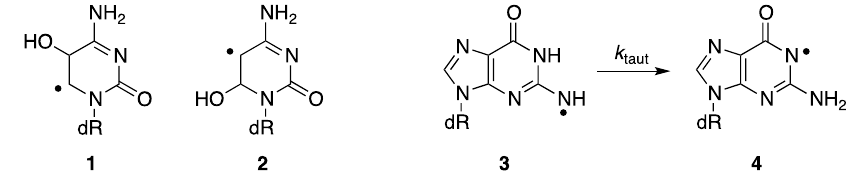
Figure 2. Transient absorption spectra recorded using PMT ( ) and ICCD ( − ); (Left) 2 µ s after electron pulse in N 2 O-saturated phosphate buffered (50 mM) aqueous solution containing 1 mM 2′ -deoxycytidine (dC); (Right) 1 µ s after electron pulse in N 2 O-saturated phosphate buffered (50 mM) aqueous solution containing 1 mM 2′ -deoxyguanosine (dG), at pH 7.